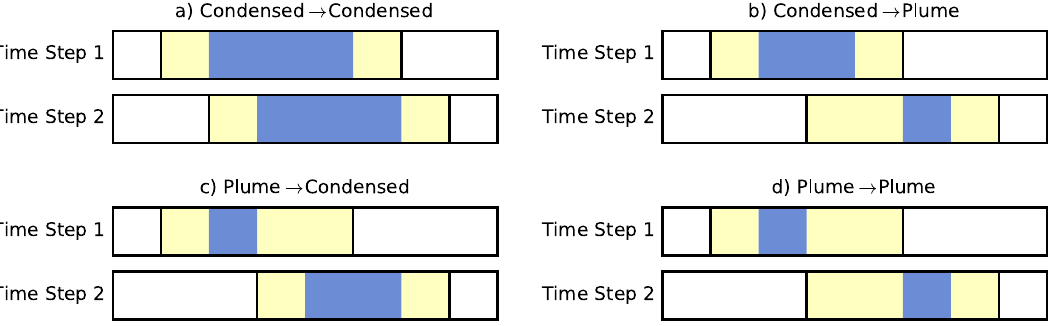
Fig. 2. The four kinds of overlap between cloudlets and tracked clouds at the previous time step. Each subfigure shows a one-dimensional representation of model points at an initial time (top) and 1 min later (bottom). Yellow indicates plume region and blue indicates condensed region. (a) A condensed → condensed overlap, with the condensed region in time step 1 overlapping the condensed region in time step 2. This subfigure also contains condensed → plume, plume → condensed, and plume → plume overlaps, but the condensed → condensed overlap takes precedence. (b) A condensed → plume connection, with the condensed region in time step 1 overlapping the plume re- gion in time step 2. This diagram also contains a plume → plume overlap, but the condensed → plume overlap takes precedence. (c) A plume → condensed connection, with the plume region in time step 1 overlapping the condensed region in time step 2. This diagram also contains a plume → plume overlap, but the condensed → plume overlap takes precedence. (d) A plume → plume connection, with the plume region in time step 1 overlapping the plume region in time step